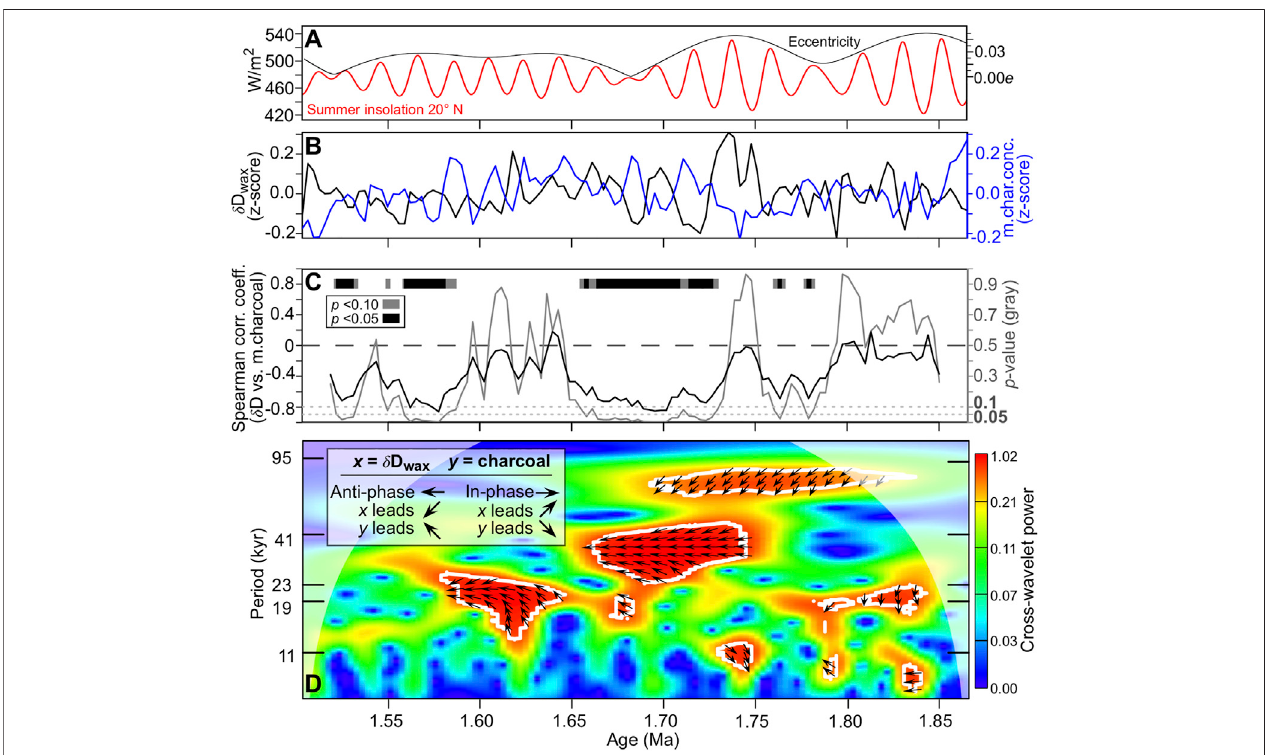
FIGURE 5 | Correlations between WTK13 core leaf wax δ D (precipitation) and microcharcoal ( fi re) records between 1.866 and 1.503 Ma. This analysis was not extended to the top of the core at 1.379 Ma because of a ∼ 30 kyr gap in the δ D record. (A) Summer insolation for 20 ° N plotted with orbital eccentricity (Laskar et al., 2004). (B) Microcharcoal concentrations (this study) and δ D wax (Lupien et al., 2018) z-scores after interpolating each record at 3100-yr time steps. Higher δ D wax values signifylowerprecipitationwhilehigher microcharcoalvaluessignifyhigher fi refrequencyand/or intensity. (C) Rolling Spearman correlations betweenthe δ D wax and microcharcoalrecords.Correlationcoef fi cients(blackline)andtheirrespective p values(grayline)werecalculatedusinga34,100-yrmovingwindow.Thegrayandblack bars represent intervals with strong negative correlations at the p ≤ 0.10 and p ≤ 0.05 levels, respectively. (D) Evolutive (periodicity through time) cross-wavelet correlations and phasing between the δ D wax and microcharcoal records. Warmer colors signify higher spectral density, and white contours with internal phase paths signify p (cid:1) 0.05 con fi dence levels. Cone of in fl uence (boundary effects) marked with white transparent shading.